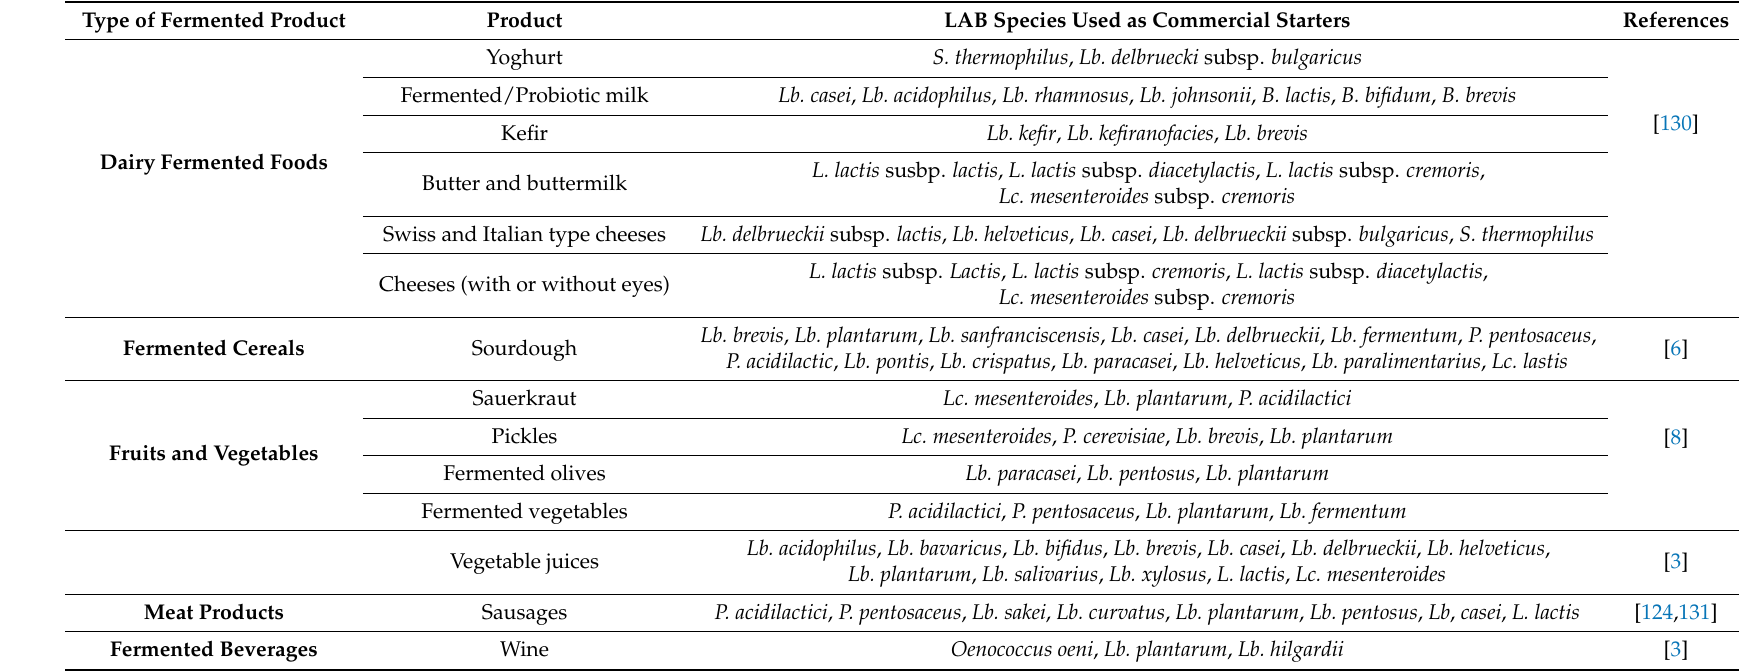
Table 3. Lactic acid bacteria used as commercial starters in the food